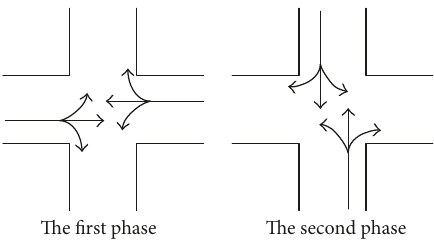
Figure 2: Phase diagram of traffic